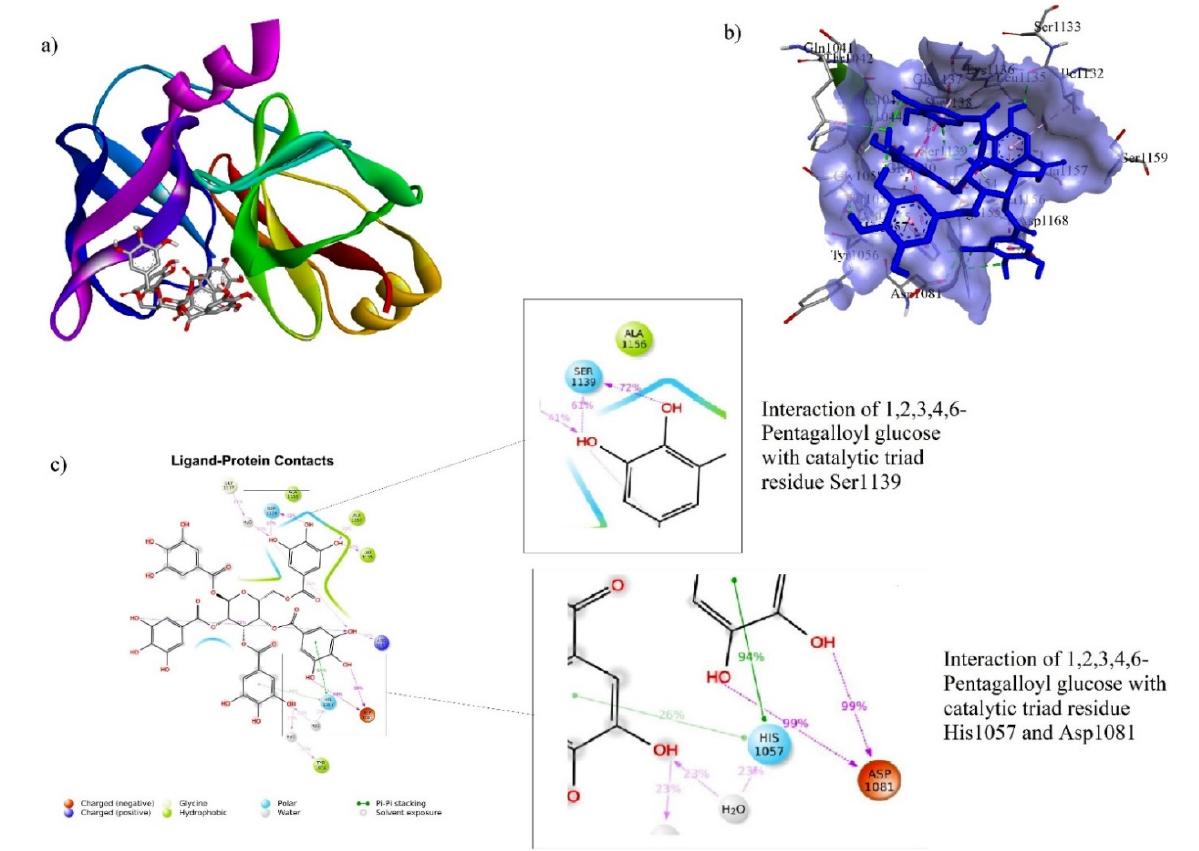
Figure 8. Intermolecular Interactions of 1,2,3,4,6-Pentagalloyl glucose with NS3/4A. ( a ) 1,2,3,4,6- Pentagalloyl glucose at catalytic triad residue site; ( b ) 1,2,3,4,6-Pentagalloyl glucose bound to NS3/4A binding pocket; ( c ) 1,2,3,4,6-Pentagalloyl glucose interactions with catalytic triad residue Ser1139, His1057, and Asp1081. Table 3. Binding affinity of prioritized phytocompounds with HCV NS3/4A.